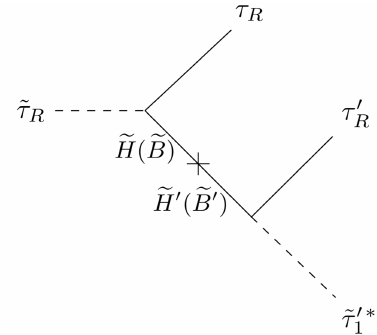
Figure 1. The lightest stau decay is mediated by mixing between higgsino and twin higgsino and/or mixing between bino and twin bino which depends on the UV completion of the model.